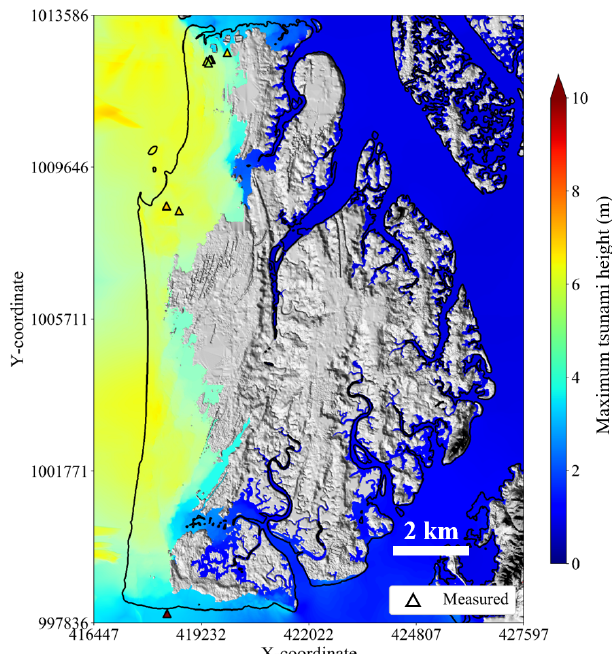
Figure 4. Comparison of calculated and measured maximum tsunami height.